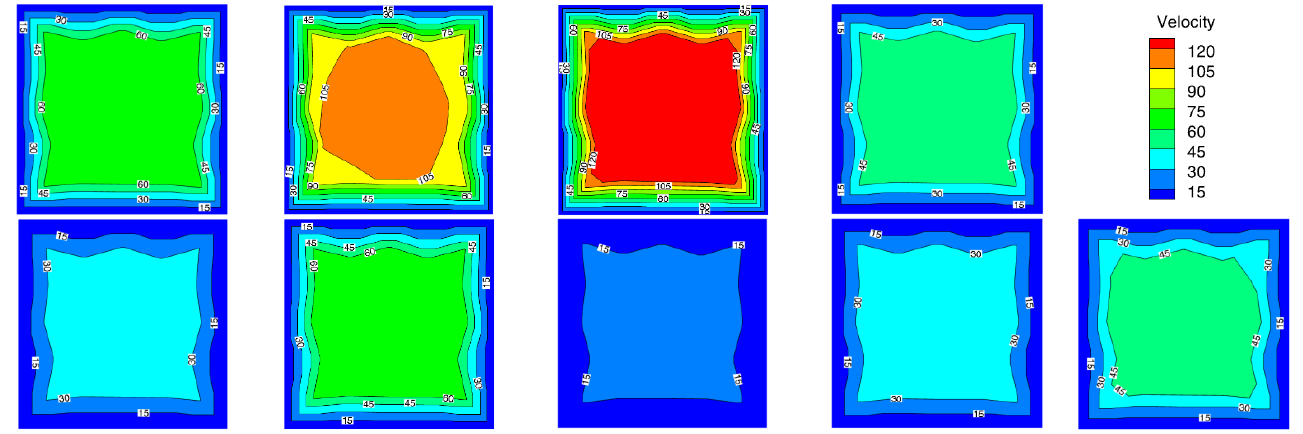
Figure 6. Air velocity of Inlet 2 of the return airway.